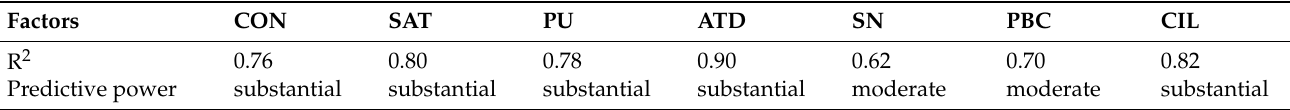
Table 6. The predictive power of each factor in the measured